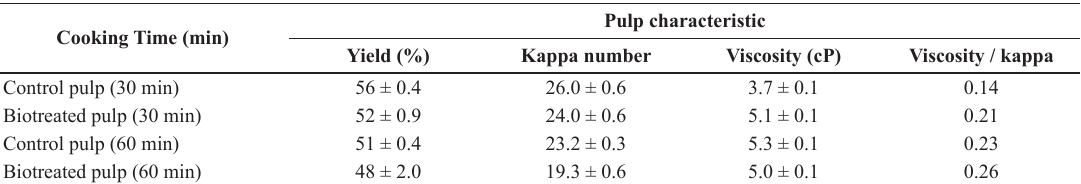
Table 2. Results of soda/AQ pulping of undecayed (control) sugar cane bagasse with cooking time ranging from 30 to 60 min. Cooking Time